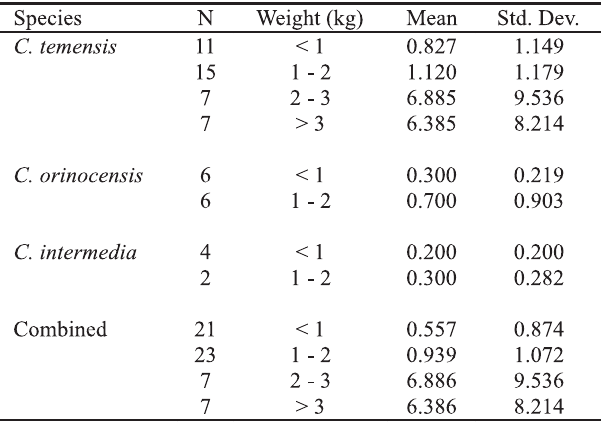
Table 2. Mean distance (km) between tag and recapture locations by species and size class at the time of